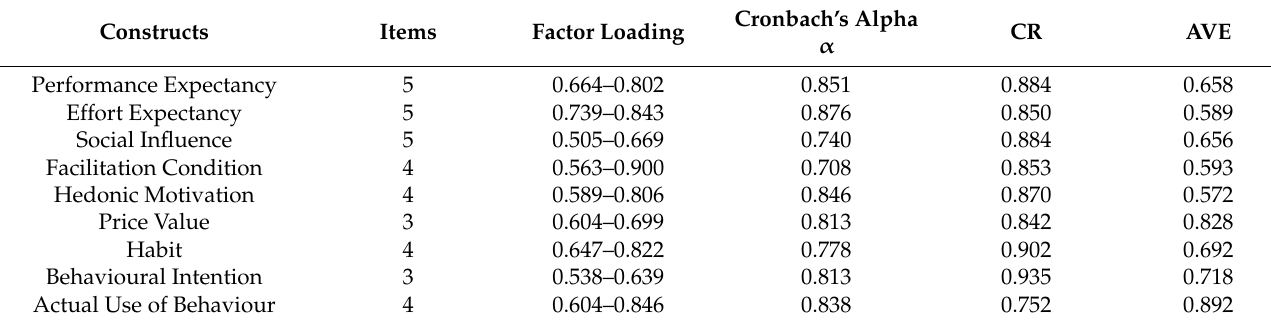
Table 2. Measurement Model